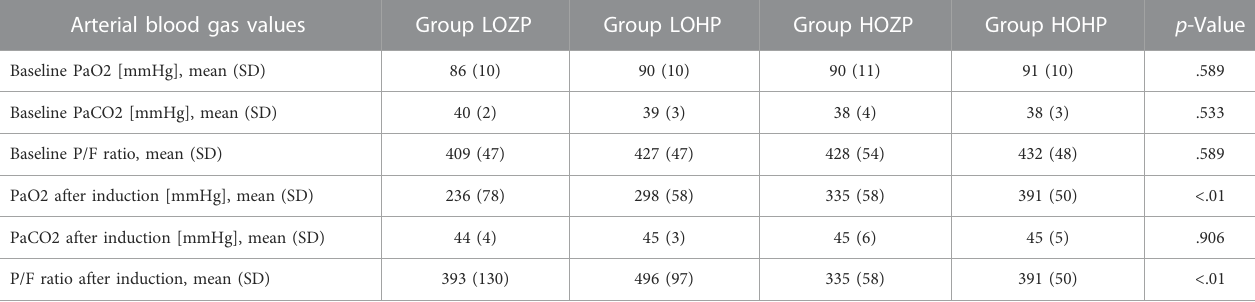
TABLE 3 The arterial blood gases before and after